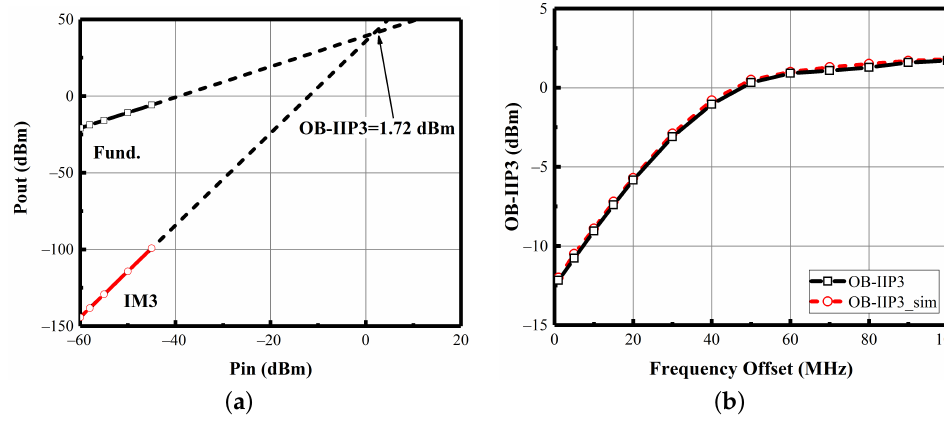
Figure 11. OB-IIP3 at 860 MHz ( a ) ∆ f = 100 MHz. ( b ) ∆ f = 1–100 MHz.